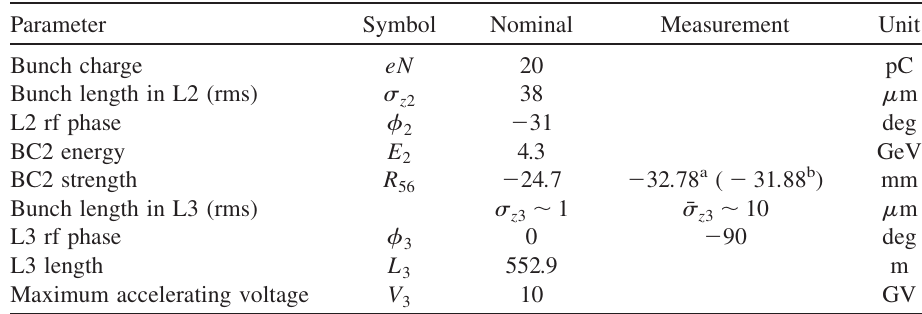
TABLE I. LCLS low-charge bunch and linac parameters used in this study. Parameter Symbol Nominal Measurement Unit Bunch charge eN Bunch length in L2 (rms)